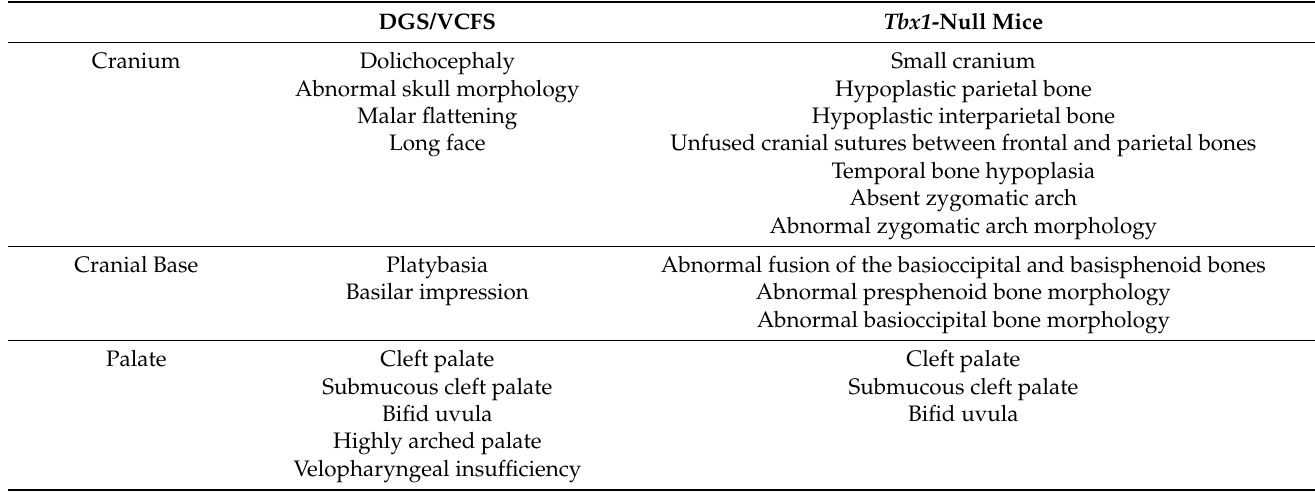
Table 2. Craniofacial and skeletal phenotypes of DGS/VCFS and Tbx1 -null